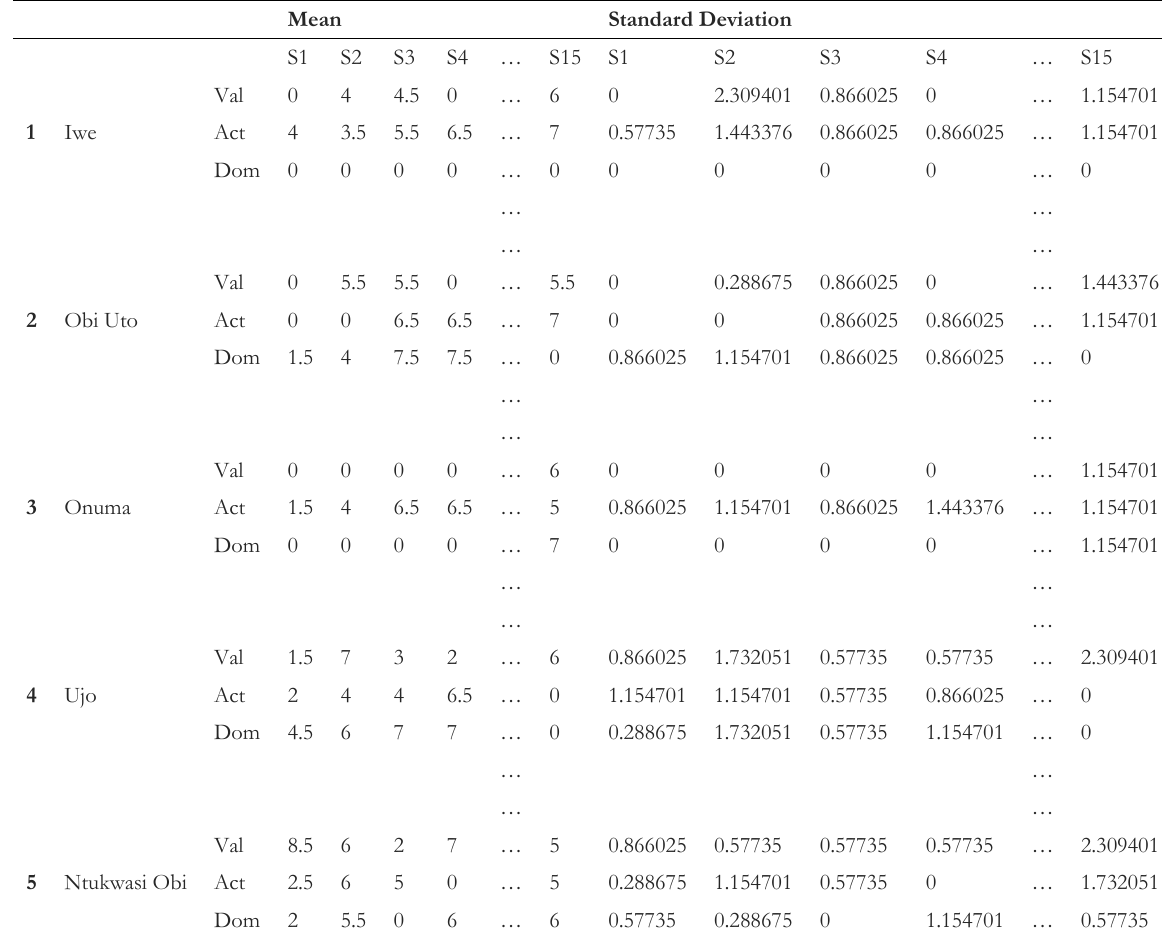
Table 9. The sample mean and SD computed for all the surviving m data intervals.